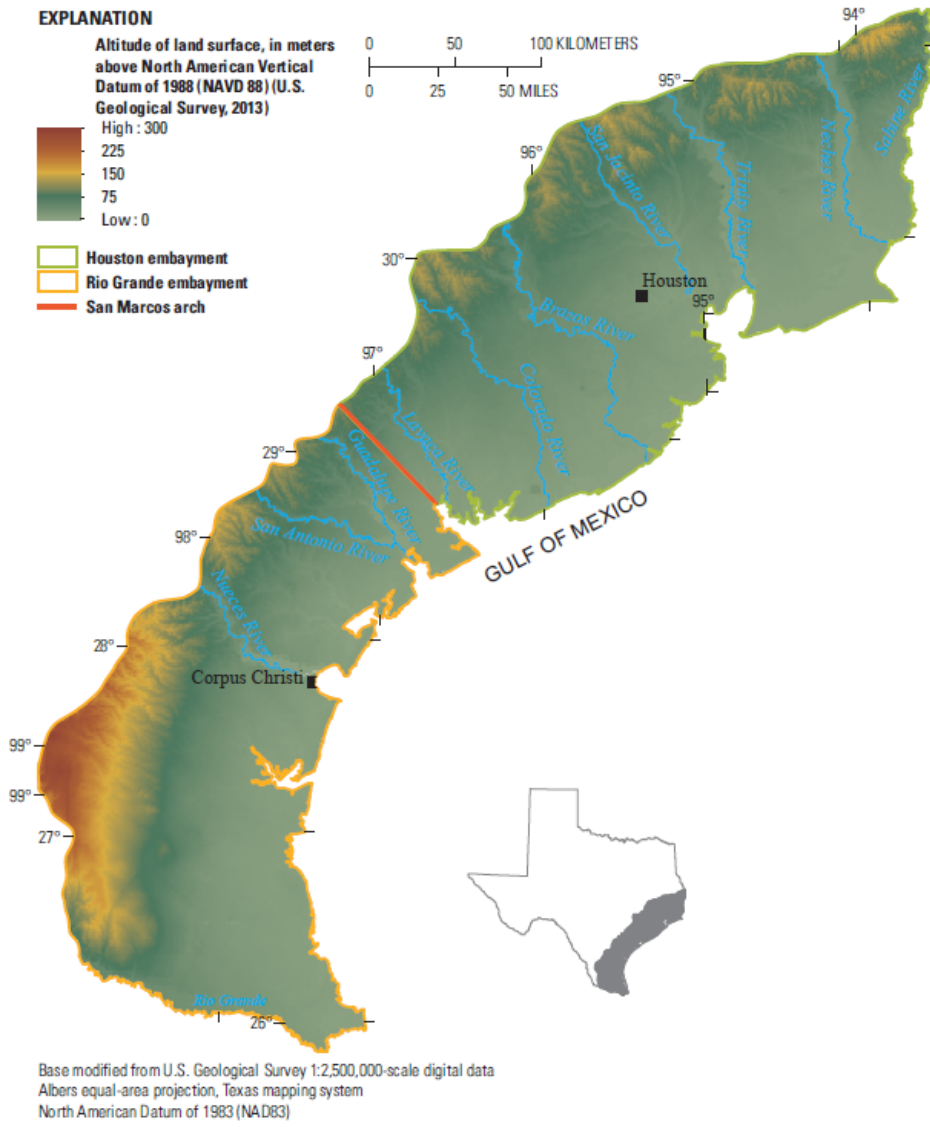
Figure 7. Land-surface altitudes [32] in permissive tract 3 within the Texas Coastal Plain.